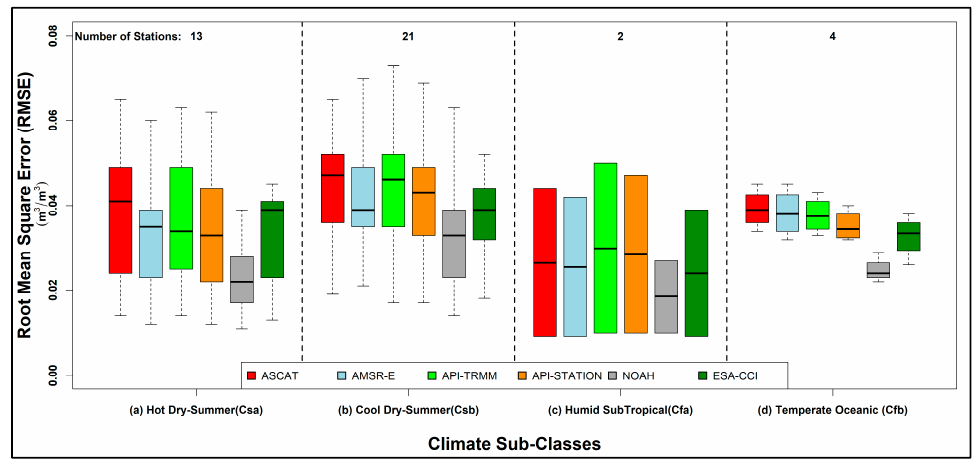
Figure 10. Correlations of soil moisture products under climate sub-classes